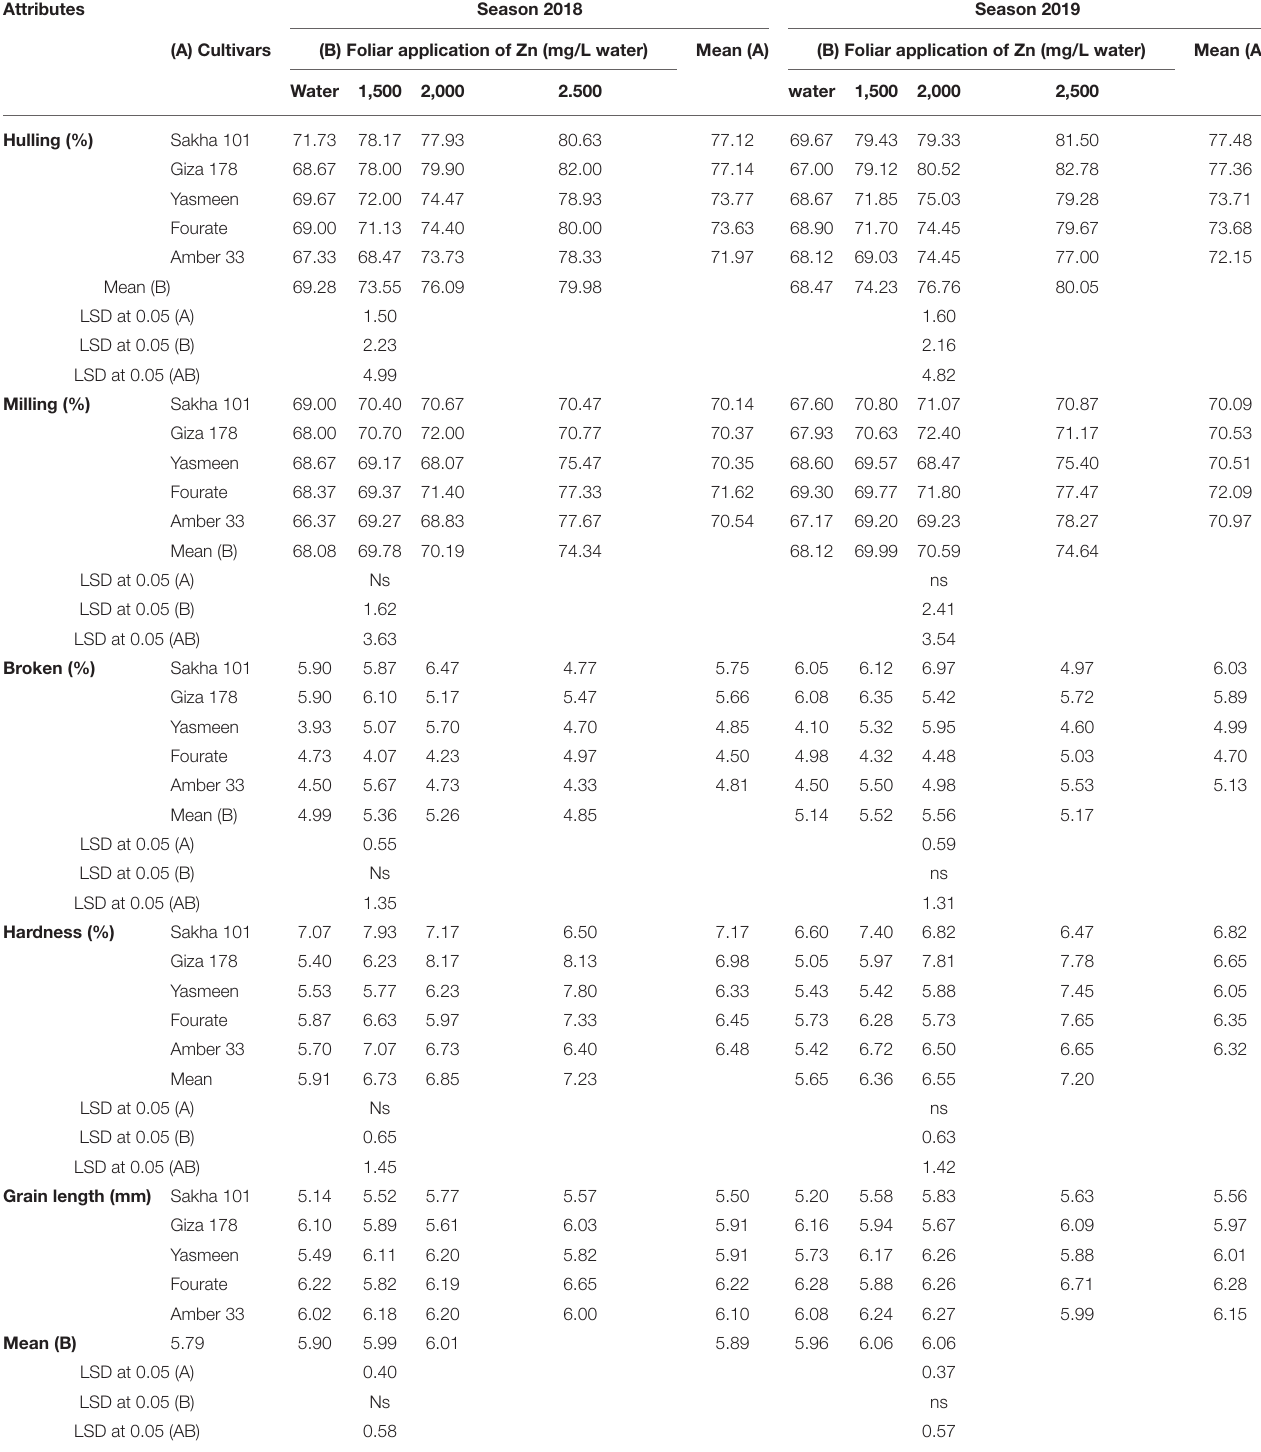
TABLE 4 | Kernel quality traits of five rice cultivars affected by the concentration of Zn during the 2018 and 2019 seasons.